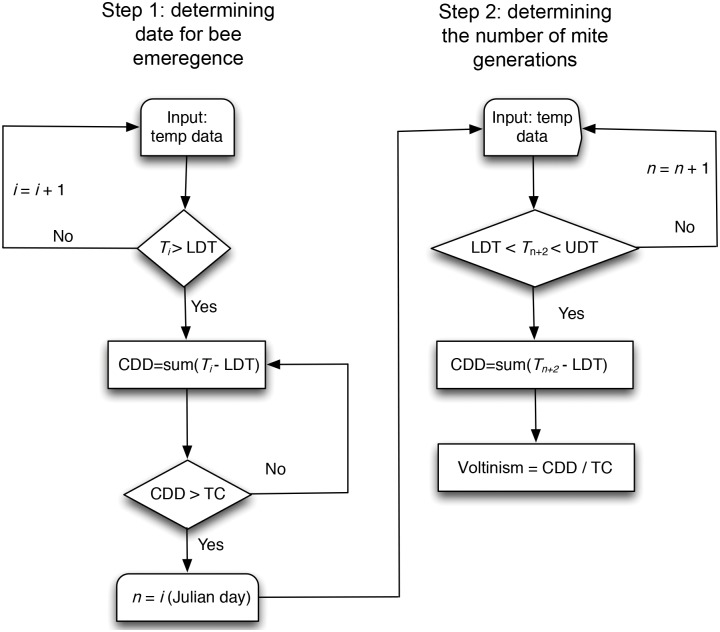
Flowchart for calculating the voltinism of C. krombeini by using the daily mean surface air temperature under the future climate scenarios.Ti, temperature at i-th date; LDT, lower temperature threshold; CDD, cumulated degree days; UDT, upper temperature threshold; TC, thermal constant.